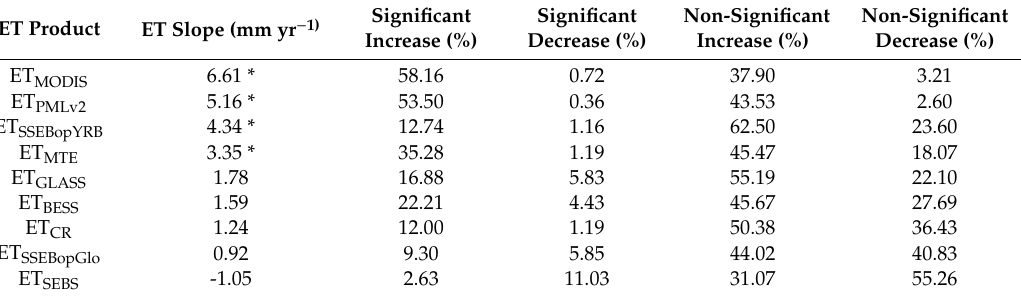
Table 4. Annual ET trend statistics for the whole YRB during the years